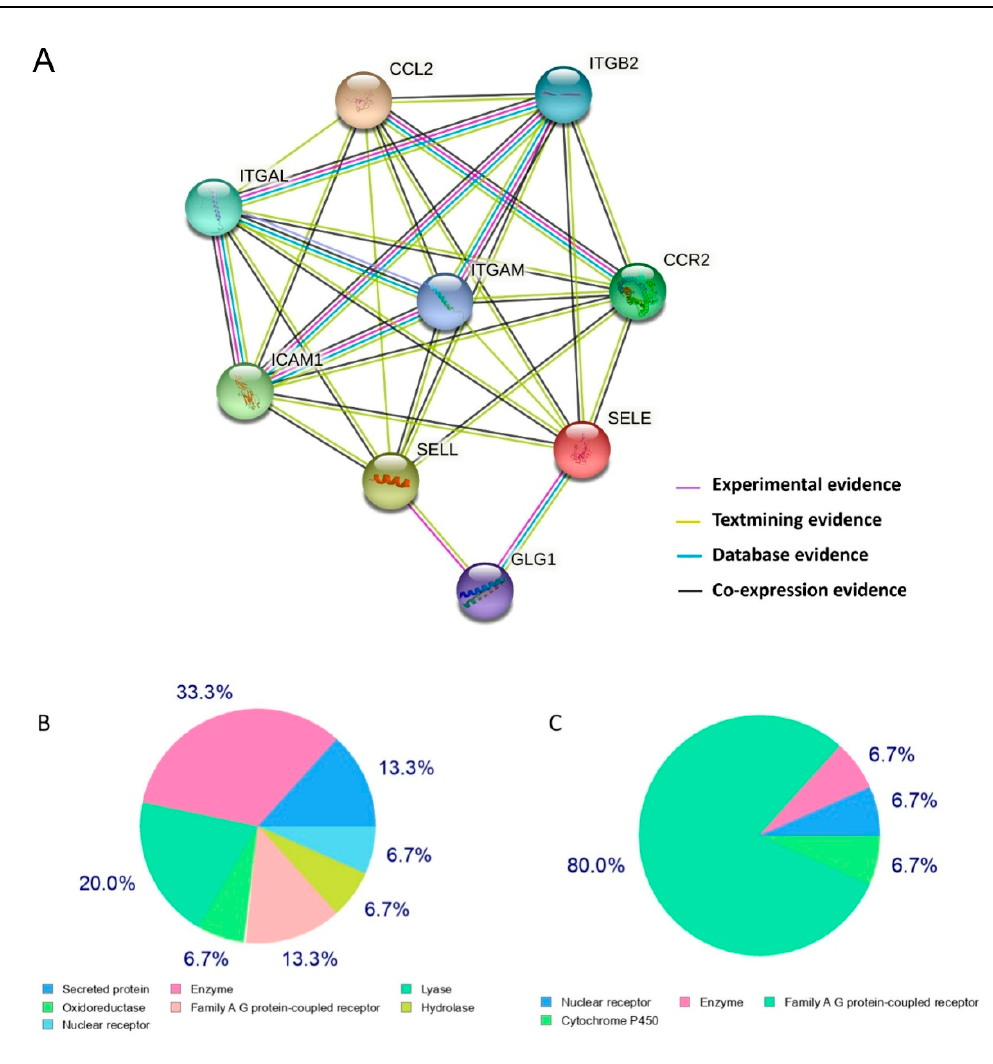
Figure 2 . Prediction of biomolecular interactions. ( A ): STRING protein–protein interaction (PPI). Nodes in the network represent proteins, and different types of interaction evidence are indicated by interconnecting colored lines (co-occurrence: blue; purple; experimental: purple; text-mining: yellow; database: light blue; co-expression: black). ( B , C ): Swiss Target Prediction of the top 15 target categories for marine bioactive compounds: fucoidan and alginate, respectively. Table 1. Analysis of swissADME for marine bioactive compounds (fucoidan and alginate).